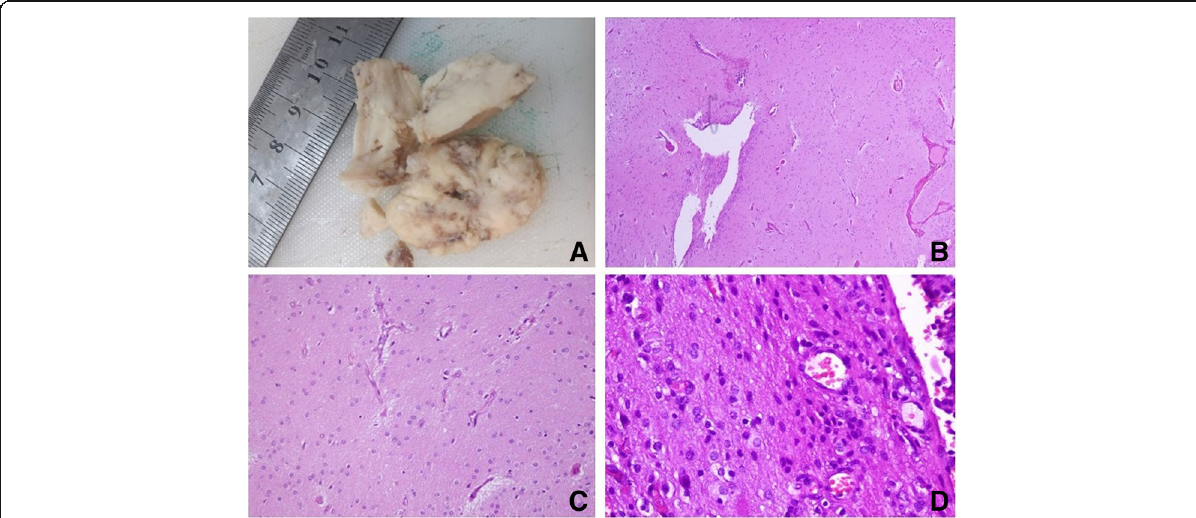
Fig. 2 a Gross examination showed a gray-white irregular tissue fragment . The cut surface showed gray to yellowish white homogenous appearance (the specimen image during additional tissue submission in the second time grossing). b , (4x magnification) and c (20x magnification), & d (40x magnification), Microscopic view showed solid tissue fragments composed of mature neural tissue comprising glial cells and astrocytes with no other germ cell layer